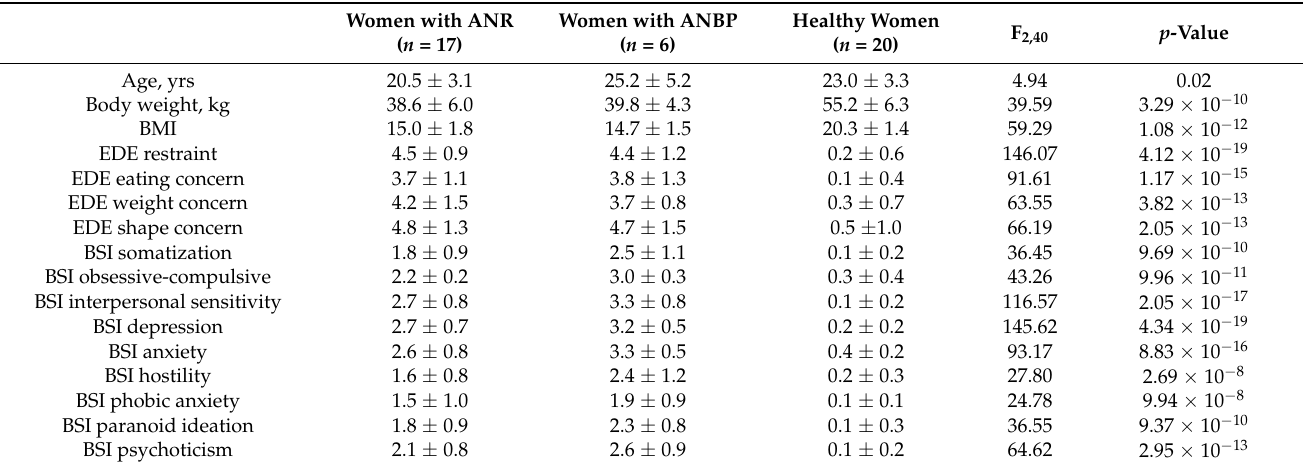
Table 1. Clinical characteristics of the study sample. Data are expressed as mean ±